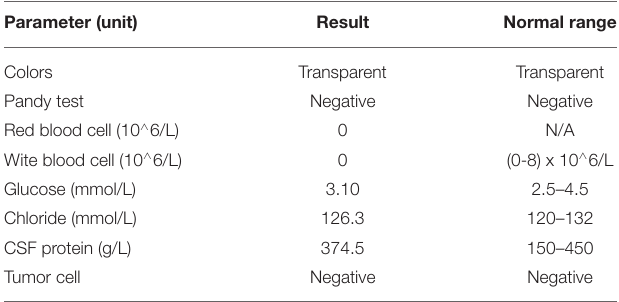
TABLE 2 | Cerebrospinal fluid test on day